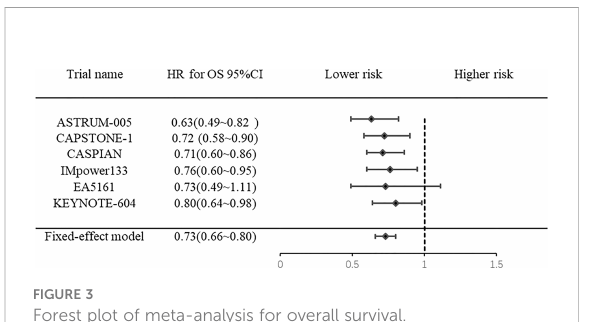
FIGURE 3 Forest plot of meta-analysis for overall survival.